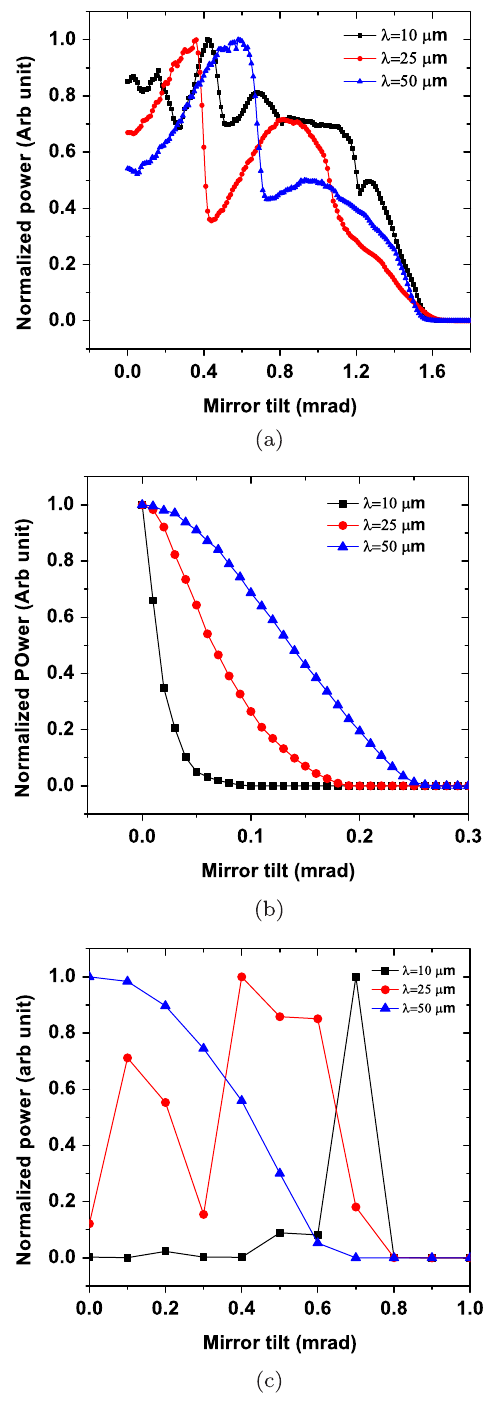
FIG. 13. Variation of outcoupled power as function of mirror tilt, for a hole size of 4 mm, at three different wavelengths for the (a) confocal ( g ¼ 0 ), (b) concentric ( g ¼ − 1 ), and (c) intermediate ( g ¼ − 0 . 6 ) configurations.